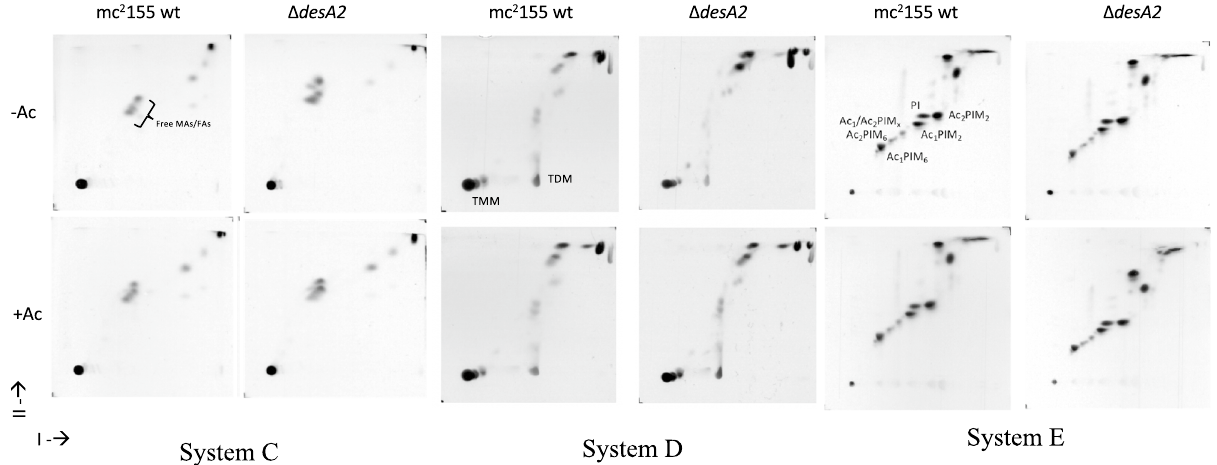
Figure 5. Autoradiographs of 2D-TLC analysis of apolar (Systems C, D) and polar lipids (System E) extracted from WT and ∆ desA2 mutant. Solvent systems C, D and E are as described by Dobson et al. 28 . Ac acetamide,